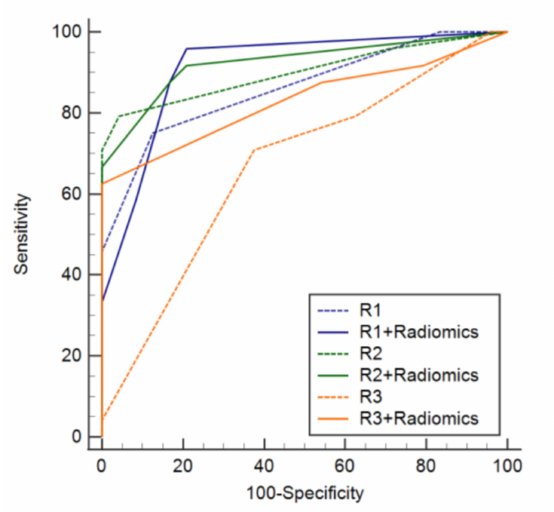
Figure 5. Diagnostic performance of the three readers with and without overall correlation with the results from the radiomics